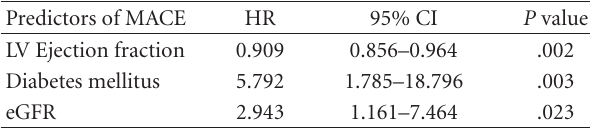
Table 3: Multivariate Predictors of MACE after